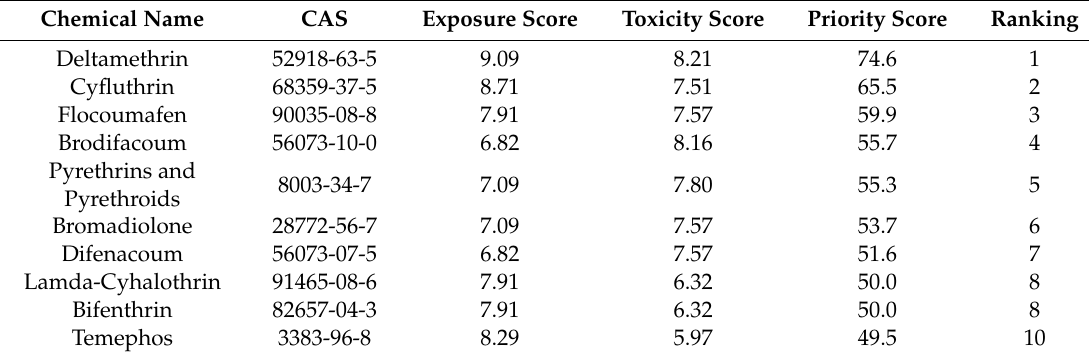
Table 4. Top 10 ranked chemicals by the priority score.